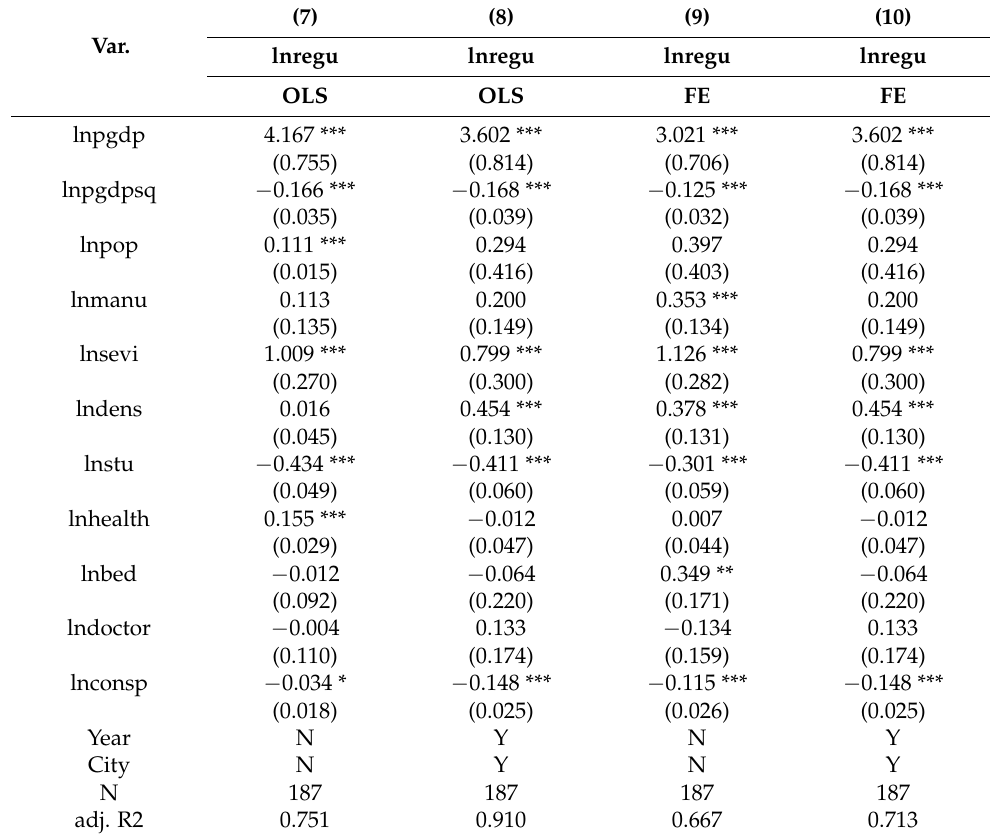
Table 3. The relationship between the economic development and environmental regulation (not the spatial